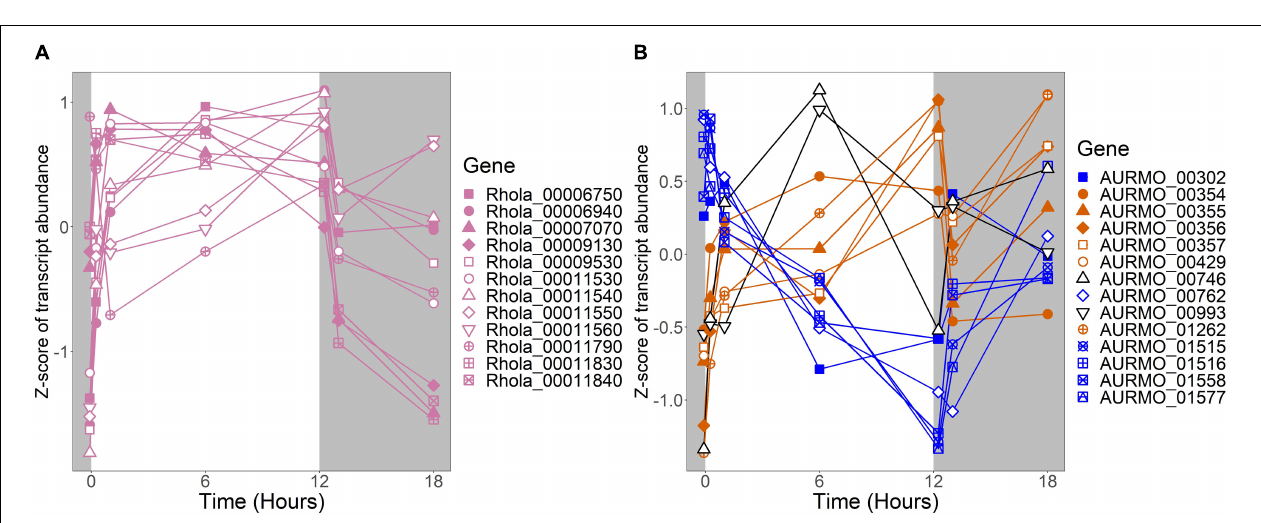
FIGURE 5 | Biological Process GO-Slim Terms with significant enrichment in expression groups. Group letters correspond to those in Figures 3 , 4 . Odds ratios were calculated as the ratio of a term’s representation in a merged group to its representation in the whole genome; any odds ratios presented here have a ratio > 1, a count in the merged group > 1, and a count in the whole genome ≥ 10. (A) GO-slim terms enriched in R. lacicola expression groups. (B) GO-slim terms enriched in A. photophilum strain MWH-Mo1 expression groups.